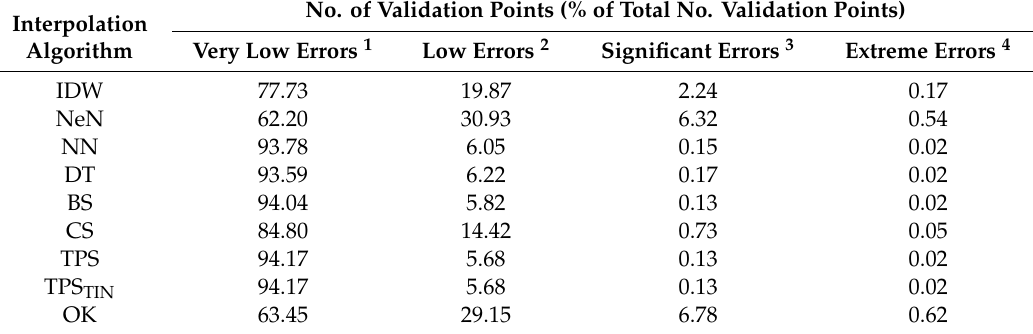
Table 4. Classification of absolute vertical errors, at the 0.5 m model